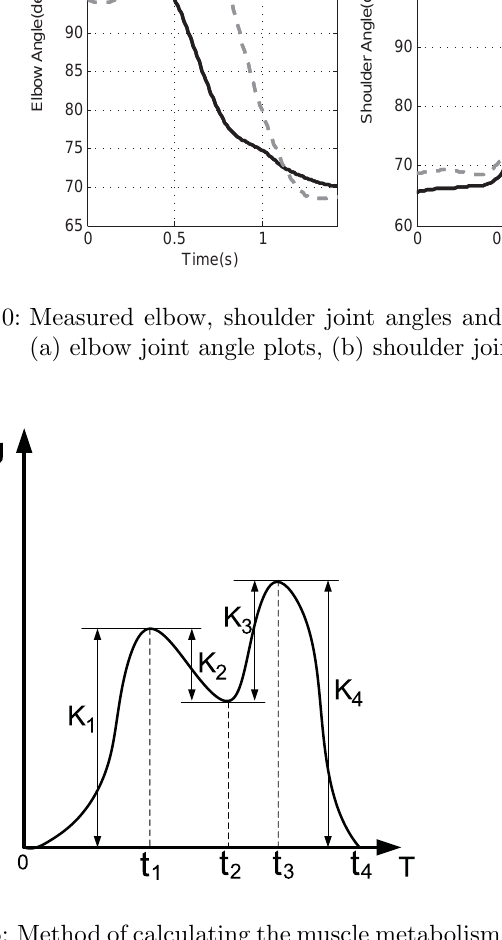
Figure 6: Method of calculating the muscle metabolism upon the arm kinetic energy profile.